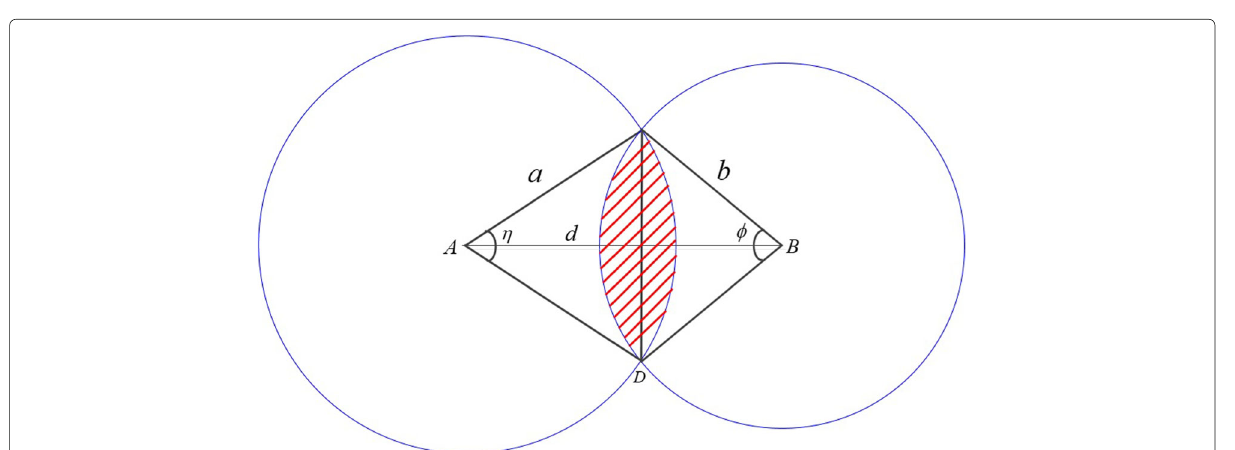
Fig. 14 Example of cooperative